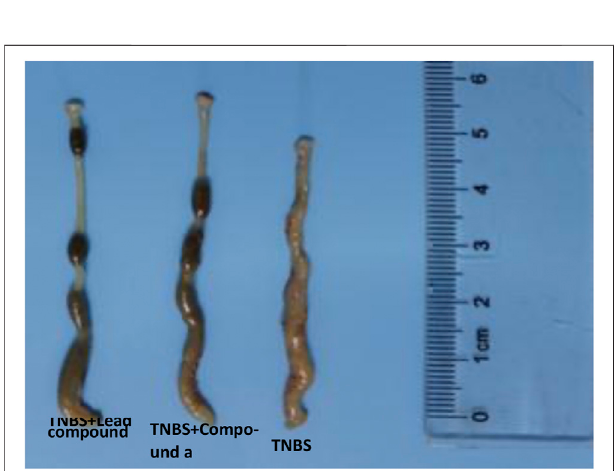
FIGURE 7 | Observation of intestinal characteristics of mice in each